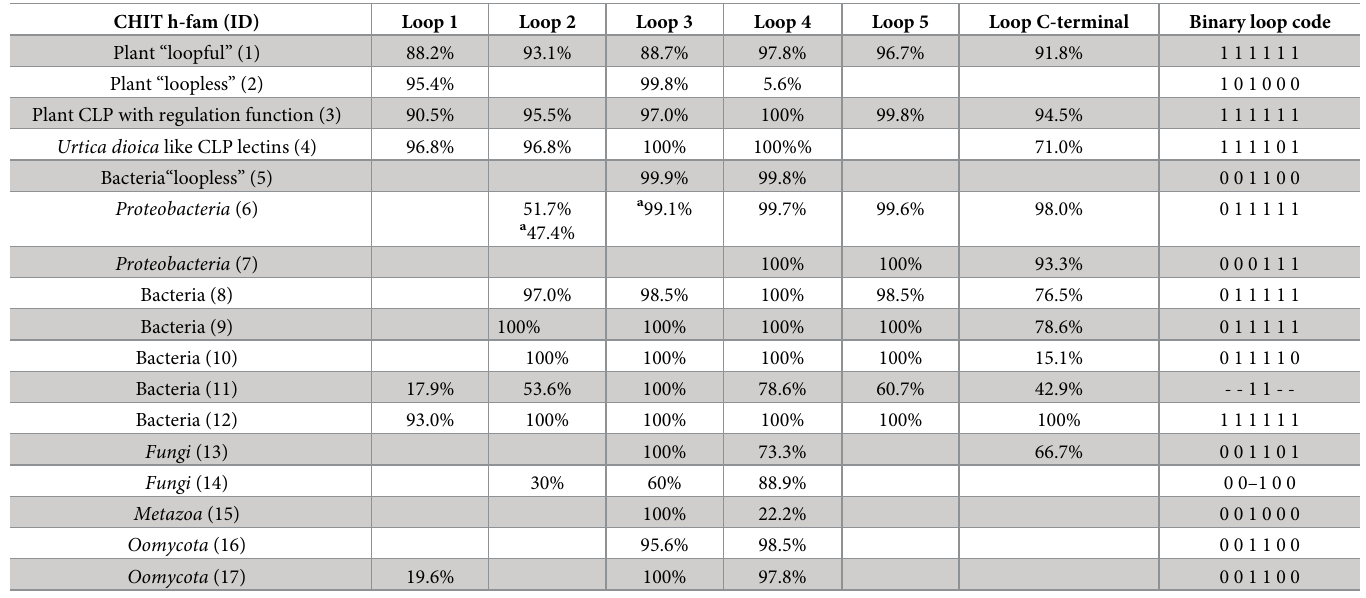
Table 3. Frequency distributions of loop annotations among CHIT groups. Names are defined according to Fig 3A (occurrences not displayed if below 5%). h- fam = homologous family (group) name in the GH19ED; ID = group identifier. Binary loop code: ‘0’ = absent; ‘1’ = present; ‘-‘ = undefined. CHIT h-fam